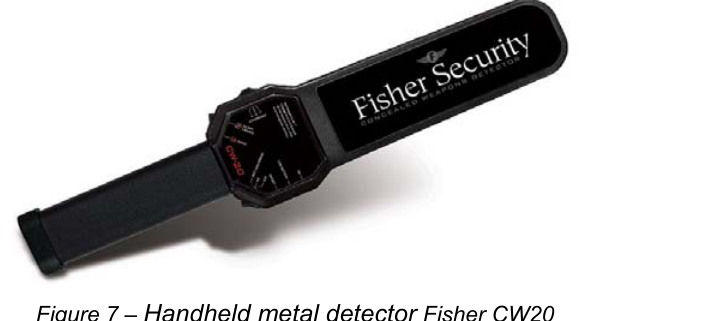
Figure 7 – Handheld metal detector Fisher CW20 Рис . 7 – Ручной металлодетектор Fisher CW20 Слика 7 – Ручни метал - детектор Fisher